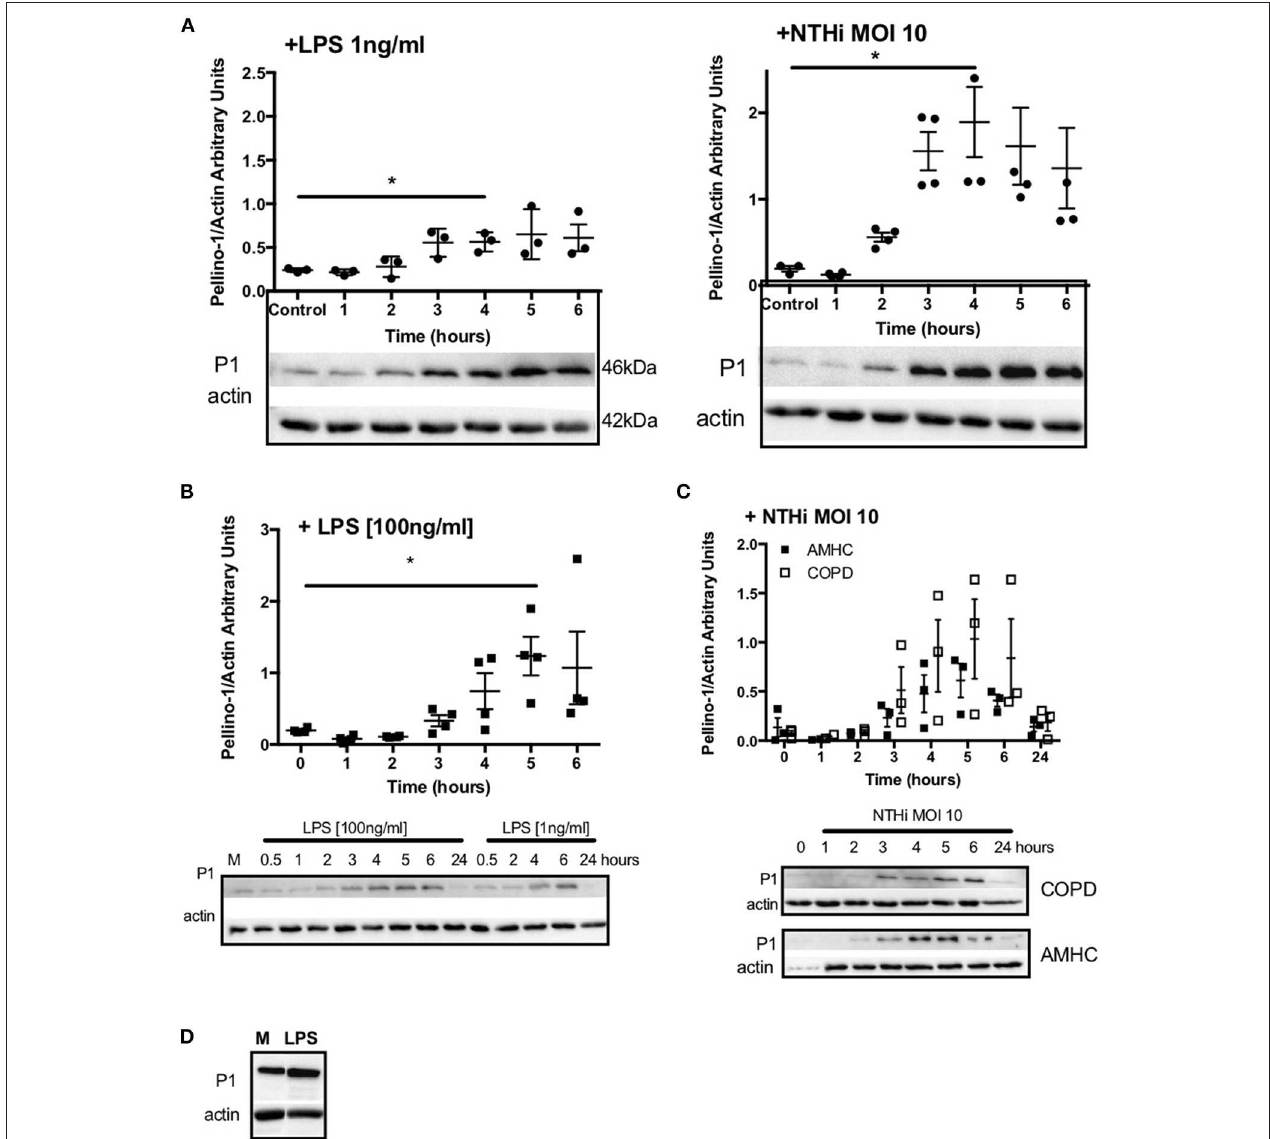
FIGURE 1 | Macrophages upregulate Pellino-1 in response to LPS and NTHi. MDMs were stimulated with LPS [1ng/ml] or NTHi (MOI 10) (A) for 1-6h. Cells were also cultured in media for 6h (control, A ). MDMs differentiated from monocytes isolated from a COPD patient were treated with LPS at 1 or 100ng/ml (B) , or NTHi MOI 10 (C) over a time course of 24h. MDMs from age-matched healthy control subjects (AMHC) were challenged with NTHi in matched experiments (C) . Primary human neutrophils were treated with LPS [1ng/ml] for 6h (D) . Lysates for all cells were prepared and subjected to Western blotting using antibodies to Pellino-1 (P1) or actin (loading control). Densitometry was performed on independent donors/experiments and data are presented as mean ± SEM. Panel d is representative of 3 experiments. Statistically significant differences are indicated by * p ≤ 0.05.